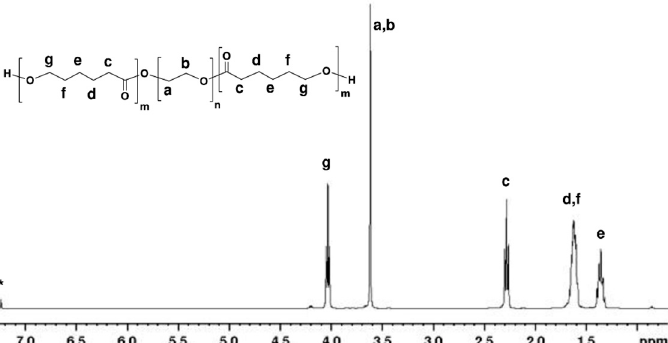
Figure 1. 1 H NMR spectrum (400 MHz, CDCl 3 , 298 K) of triblock PCL-PEG-PCL copolymer.